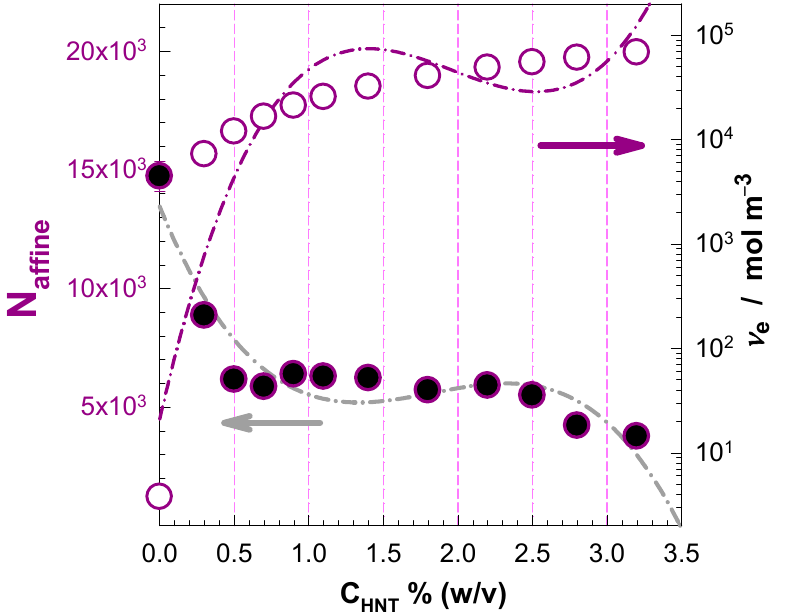
Figure 7. Variation of the average network chain length N af f calculated assuming affine network model and the effective crosslink density ν e of ternary hybrid HNTm/PHAD-Hgs network as a function of HNT content.